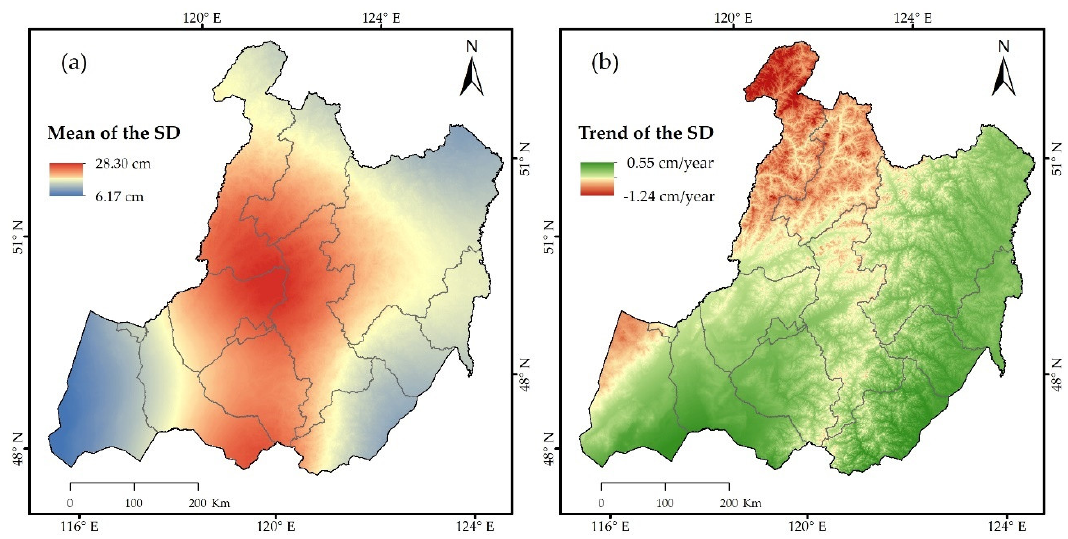
Figure 5. Distribution of ( a ) mean of snow depth and ( b ) trend of annual snow depth in 2001–2018.